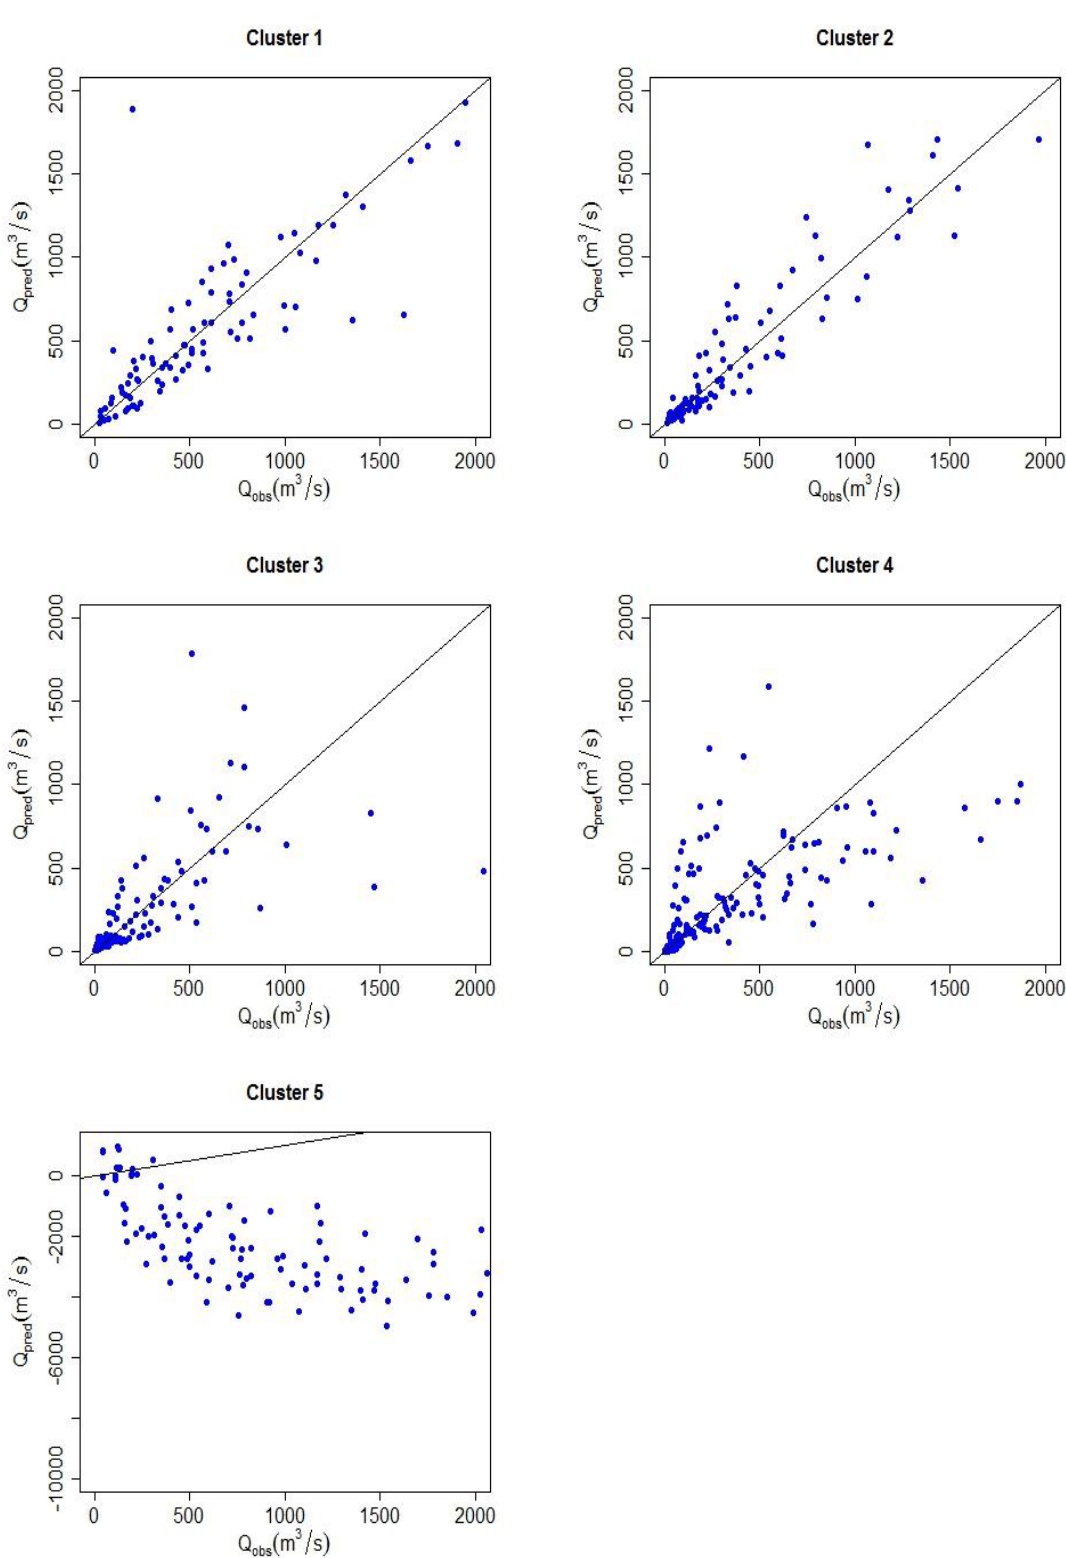
Figure 13. Comparison of observed and predicted flood quantiles for all the quantiles and clusters.